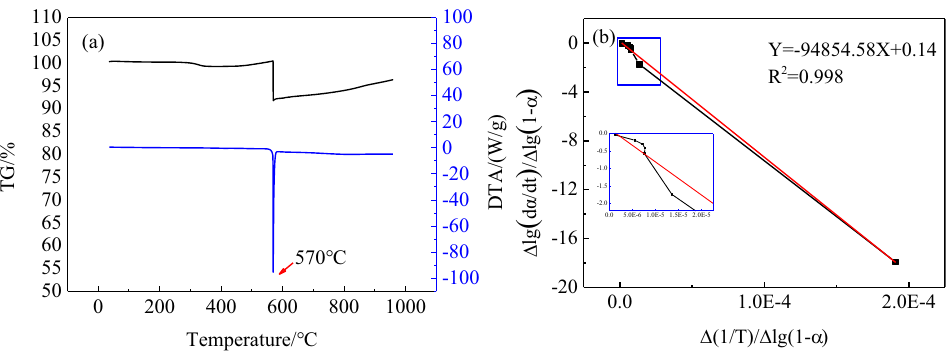
Figure 1: ( a ) TG – DTA curve of the V 2 O 5 – Mg system. ( b ) The fi tting curve of the relationship between Δ lg ( d α /d t ) / Δ lg ( 1 − α ) − Δ ( 1/ T ) / Δ lg ( 1 − α ) when the heating rate is 10°C min − 1